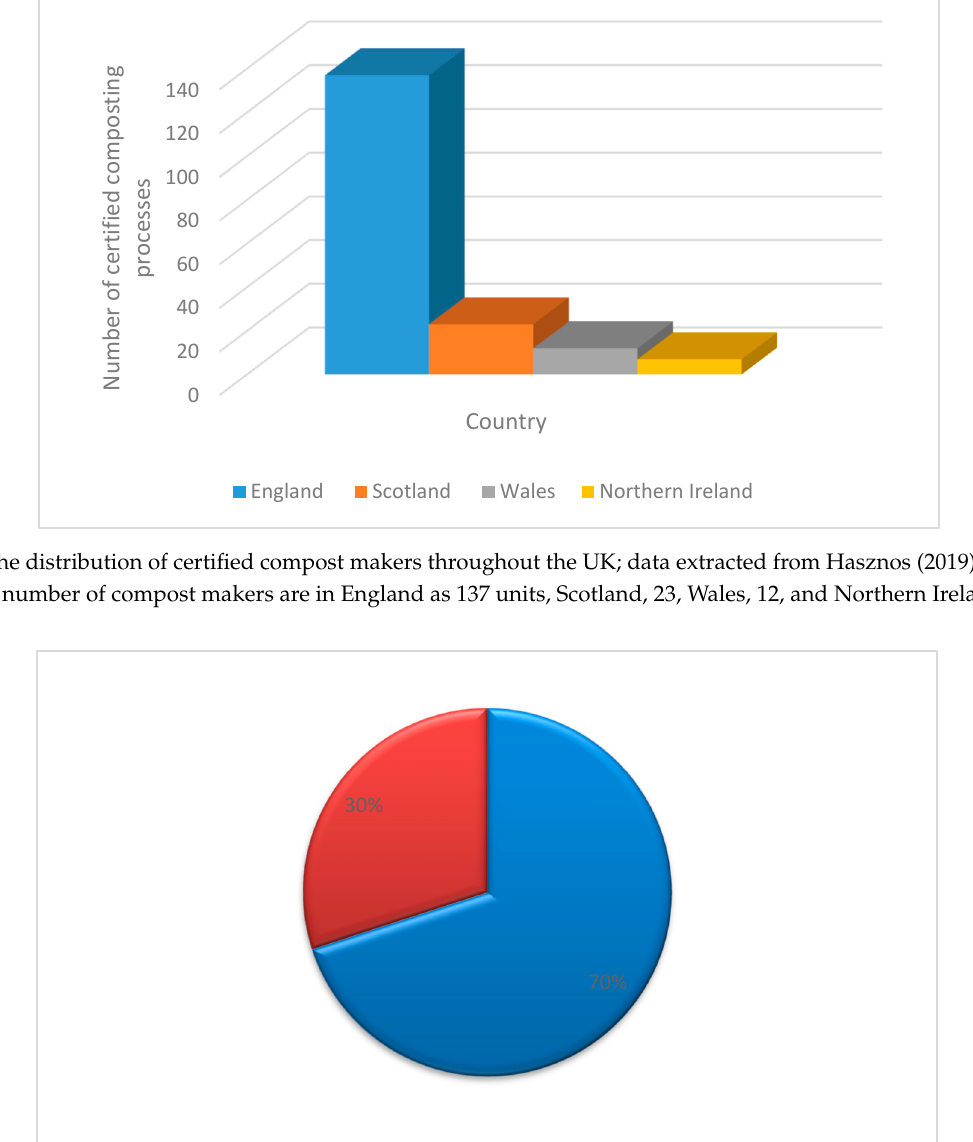
Figure 3. The type of waste materials processed at certified waste centres in Scotland; data extracted from Hasznos (2019) shows that the waste centres in Scotland are processing green waste [127] .